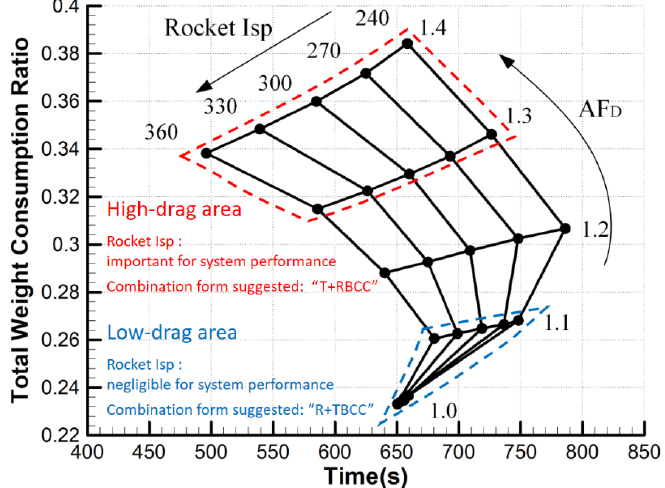
Figure 17. Total weight consumption ratio and flight time under different rocket Isp and AF D .